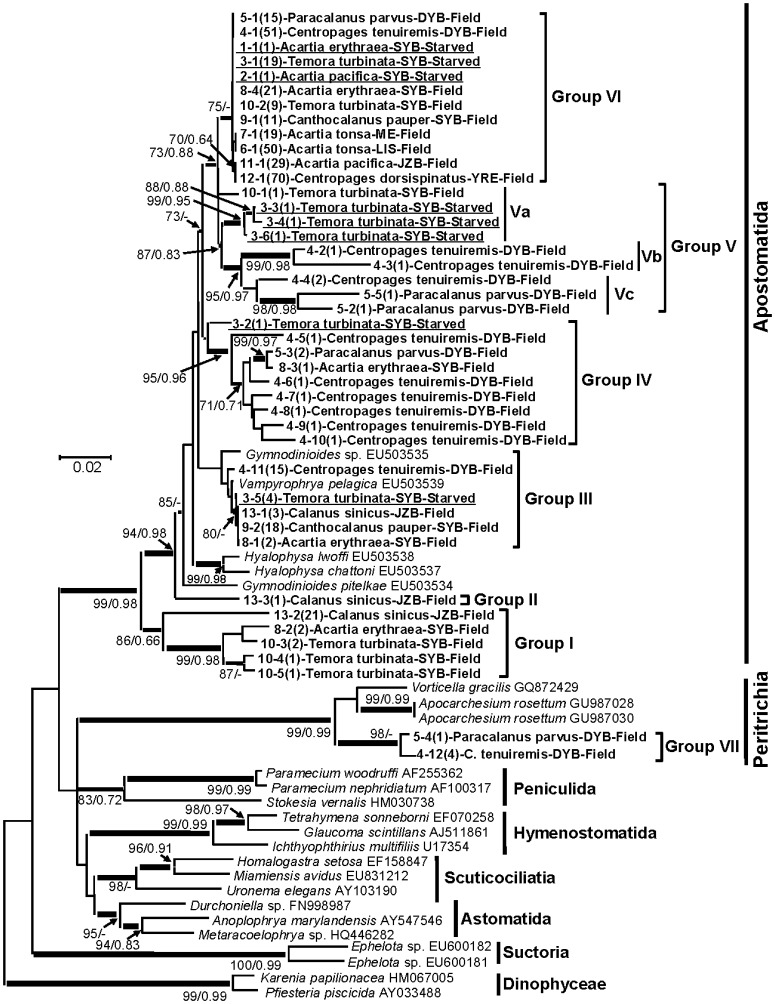
Neighbor joining and maximum likelihood analyses of 18S rDNA sequences.Phylogenetic tree inferred from partial 18S rDNA sequences retrieved in this study and the related organisms available in GenBank. Shown at nodes are bootstrap value from Neighbor-Joining (left) and SH-like value of maximum likelihood (right) trees; only values >70%/0.6 at critical nodes are shown. The thickest branches denote bootstrap values of >90%, medium-thick branches values of 70 to 90%, and thin branches values of <70%. The numbers at nodes are bootstrap confidence values based on 1000 replicates for NJ analysis and 500 for ML analysis, while the numbers in parentheses indicate number of identical sequences obtained. The scale bar indicates the substitutions rate per nucleotide. LIS, Long Island Sound, Connecticut, USA; ME, Penobscot Bay, Maine, USA; DYB, Daya Bay, China; SYB, Sanya Bay, China; JZB, Jiaozhou Bay, China; YRE, Yellow River Estuary, China. “Starved” denotes the sequences retrieved from gut-purged starved copepods, while “Field” from in situ fixed copepod samples.